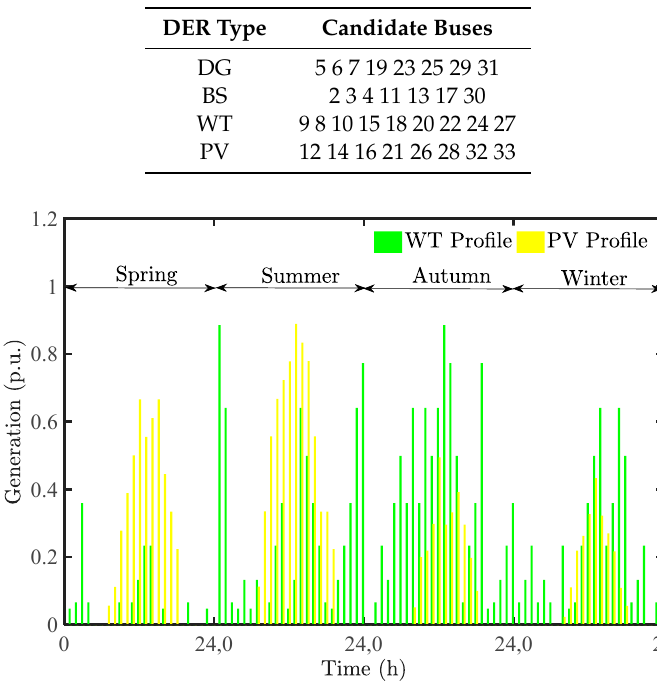
Table 6. Candidate Buses for DER Integration.